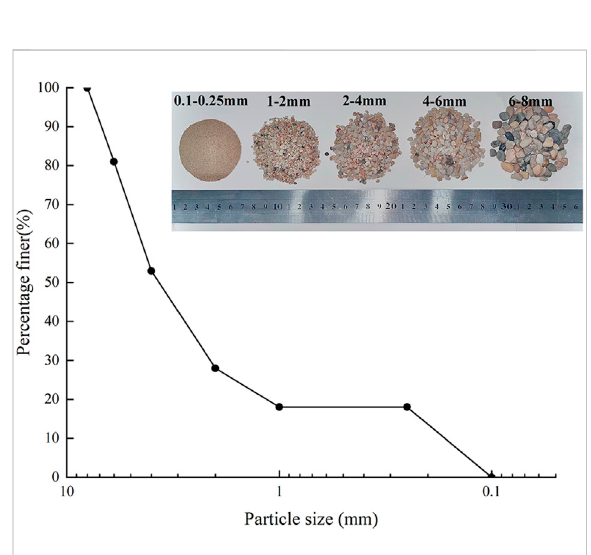
FIGURE 3 Particle size distribution curve and photographs of